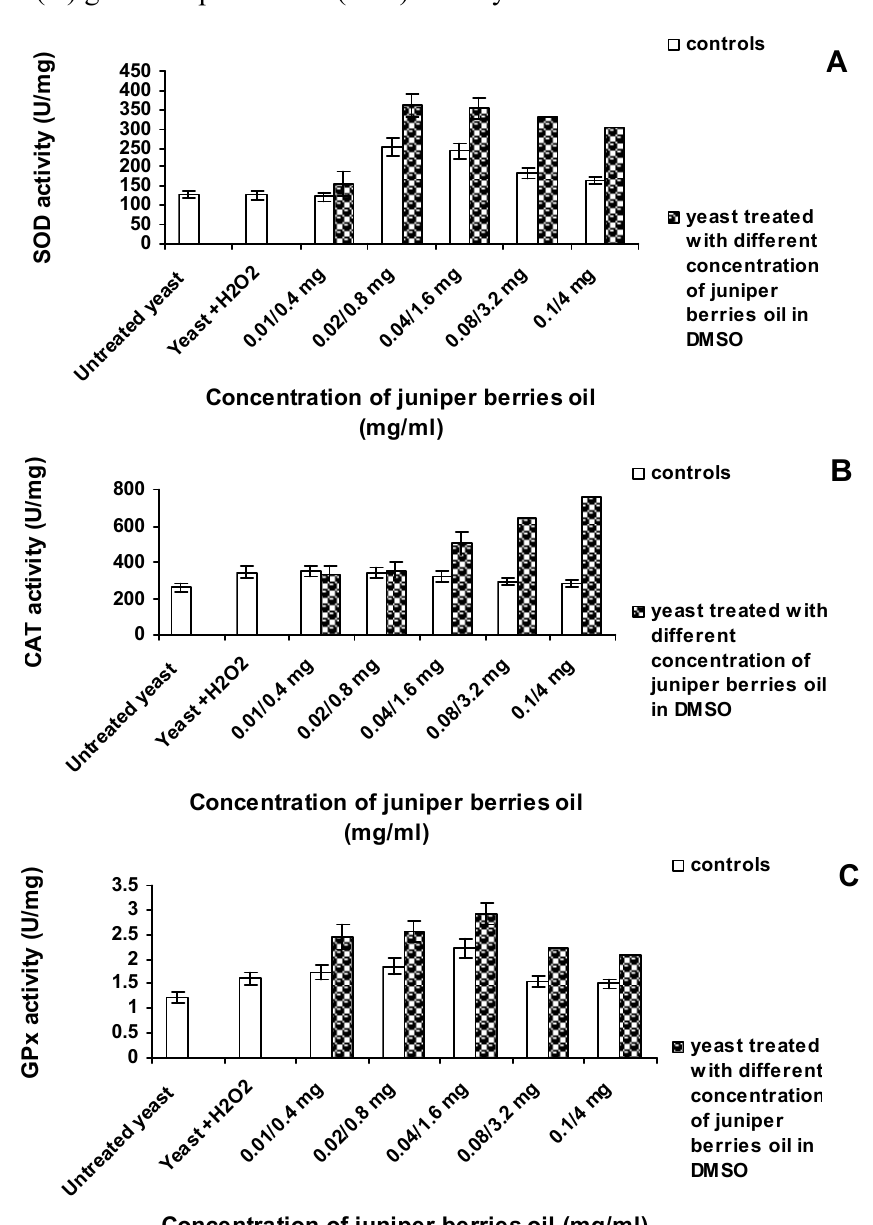
Figure 3. Effect of juniper berry oil on ( A ) superoxide dismutase (SOD), ( B ) catalase (CAT) and ( C ) glutation peroxidase (GPx) activity in S. cerevisiae